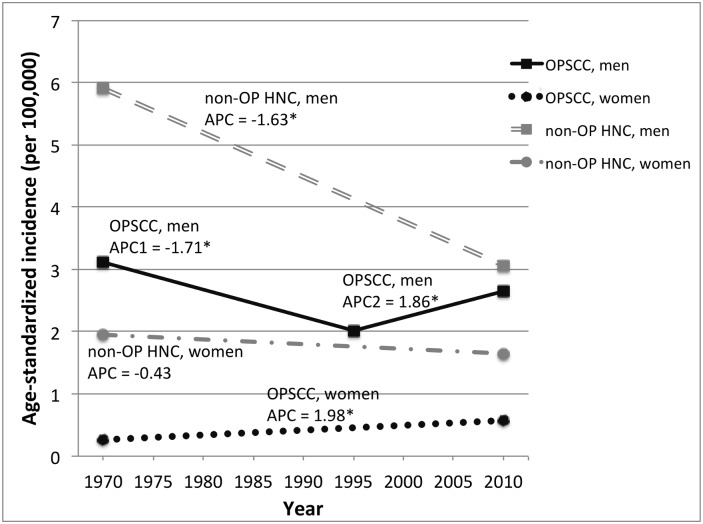
Incidence of oropharyngeal and non-oropharyngeal head and neck squamous cell carcinomas in Singapore 1968–2012, by gender.Incidence trends are based on incidence rates for 5-year time periods that were age-adjusted to the WHO standard population. Annual percent change (APC) was calculated using Joinpoint regression analysis. APC = annual percent change. An asterisk (*) indicates an APC value that is statistically significant at p≤0.05. Abbreviations: OPSCC = oropharyngeal squamous cell carcinoma; non-OP HNC = non-oropharyngeal head and neck squamous cell carcinoma